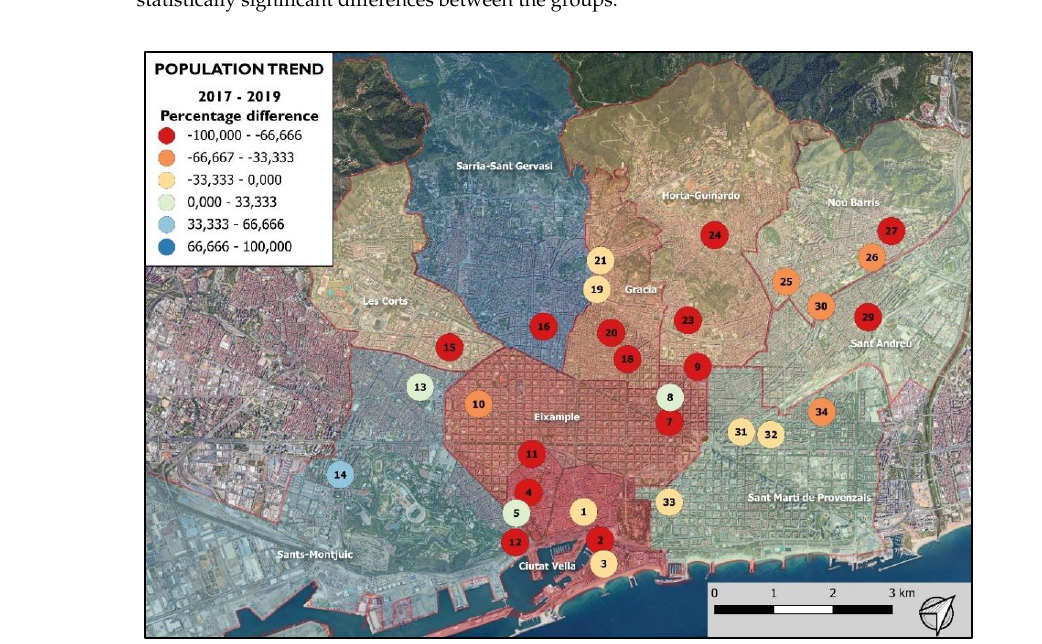
Figure 8. Heat map of the population trends registered in the pigeon colonies throughout the study period, from 2017 pre-treatment to 2019 post-treatment.